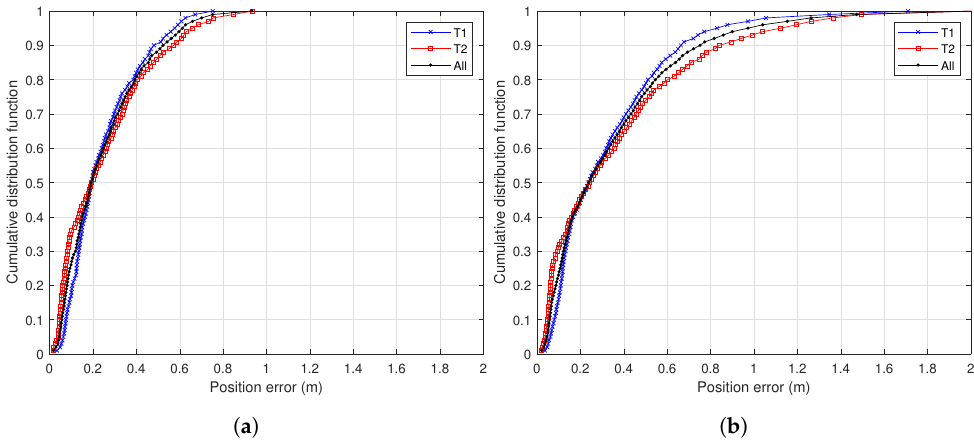
Figure 11. Cumulative distribution function plots of ( a ) Flights 1–4 and ( b ) Flights